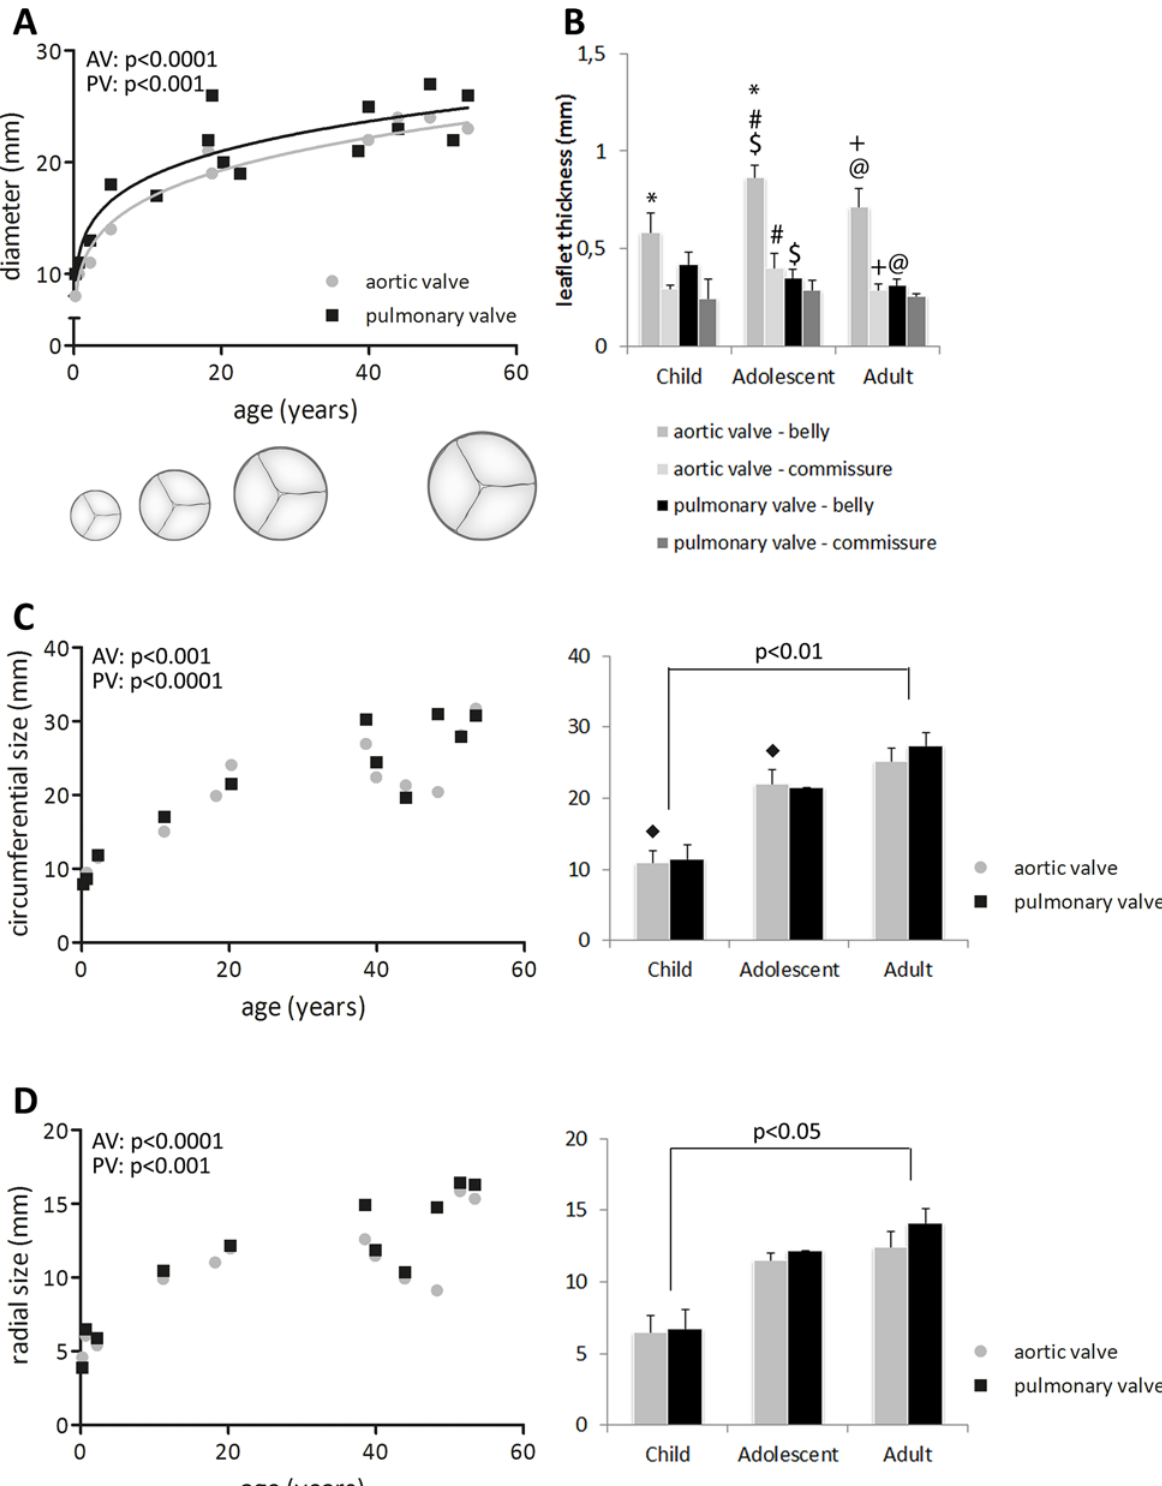
Fig 2. Evolution of valve dimensions. (A) Increase in annulus diameter in the aortic (grey) and pulmonary (black) valve. The diameter increases rapidly early in life and slowly, but continuously, thereafter. The pulmonary valve is slightly larger compared to the aortic valve. (B) The thickness of the leaflets is heterogenous and larger in the belly compared to the commissures, which is similar for all age groups. Aortic valves are slightly thicker than pulmonary